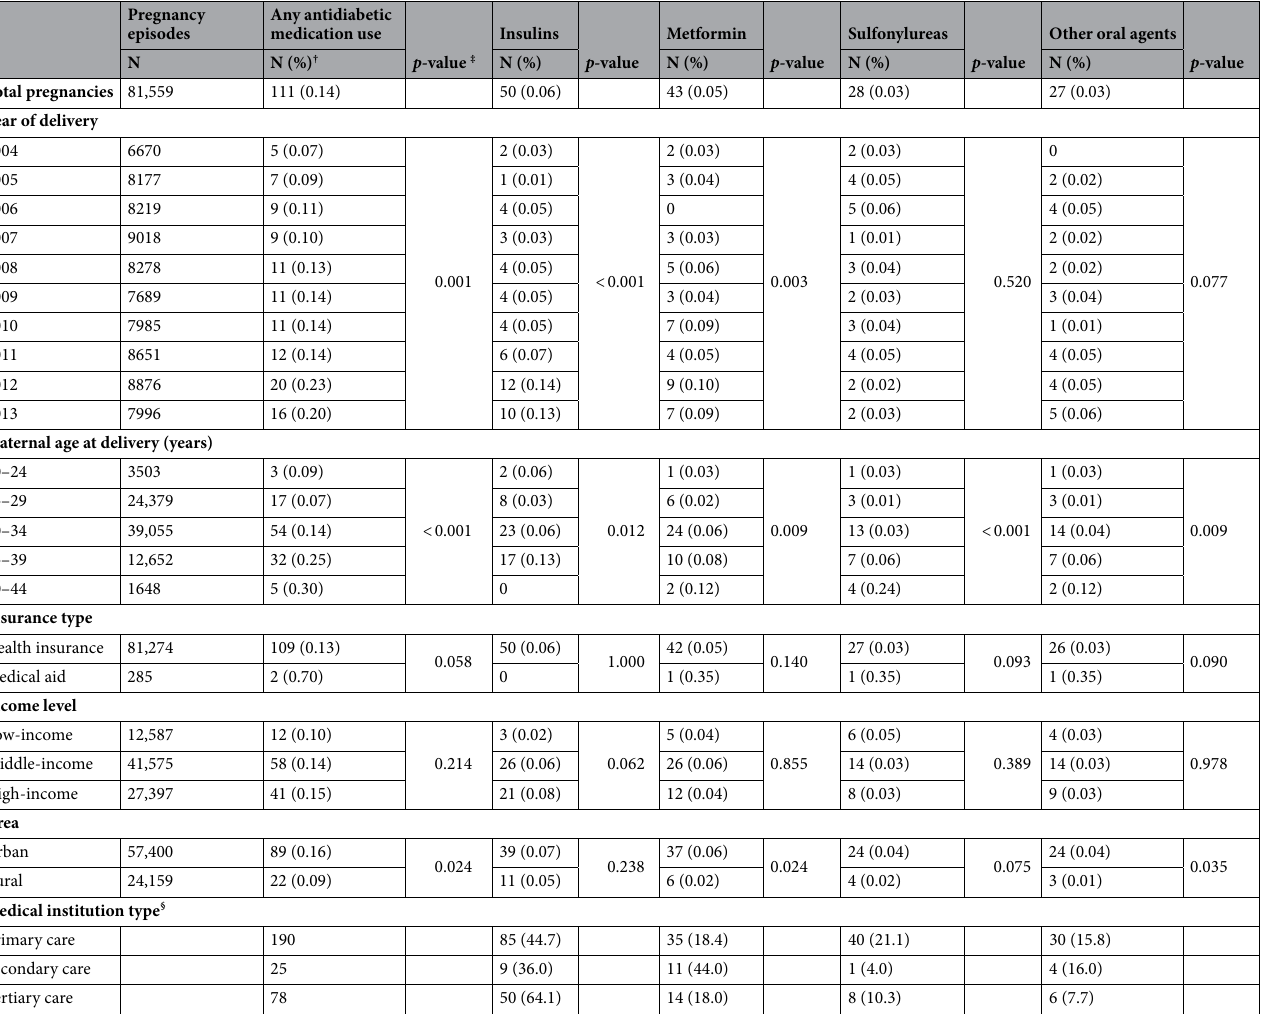
Table 3. Utilization of antidiabetic medications during the first trimester, by drug class * and maternal characteristics, 2004–2013 (N = 81,559). *When a pregnant woman was prescribed two or more drug’s active ingredient, each ingredient was separated individually. † All percentages are row percentage with pregnancies corresponding to each row. ‡ The p -value s denote comparison between pregnancies with and without prescriptions of each drug class. The χ 2 test or Fisher’s exact test was used for variables of insurance type and area, and the Cochran-Armitage trend test was used for variables of the calendar year, maternal age, and income level. p values of < 0.05 were significant. § In the case of medical institution type, we used the number of prescriptions and not the number of